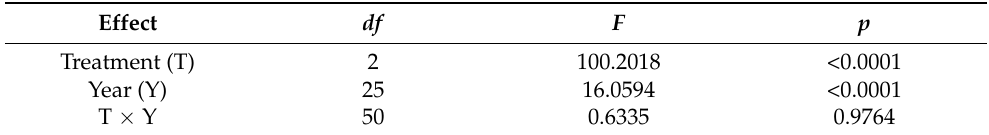
Table 4. Analyses of variances (ANOVAs) for the effect of treatment (untreated control, IPM, healthy- standard treatment), year (1995–2021), and their interaction on yield